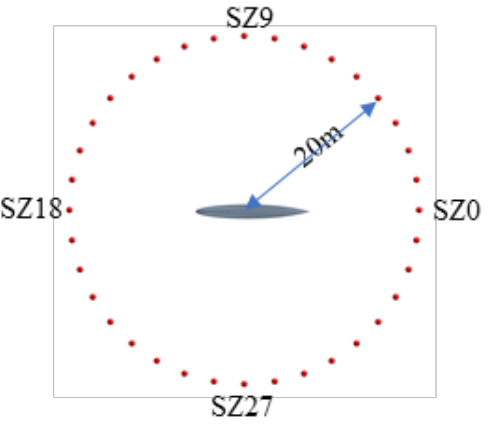
Figure 11. Position of monitoring points on the horizontal section.